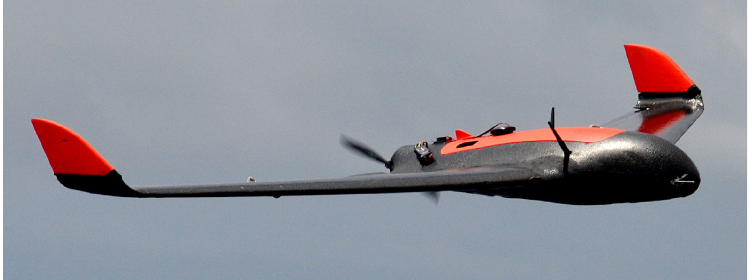
Figure 1. Skywalker X8 fixed-wing UAV (Image courtesy of NTNU